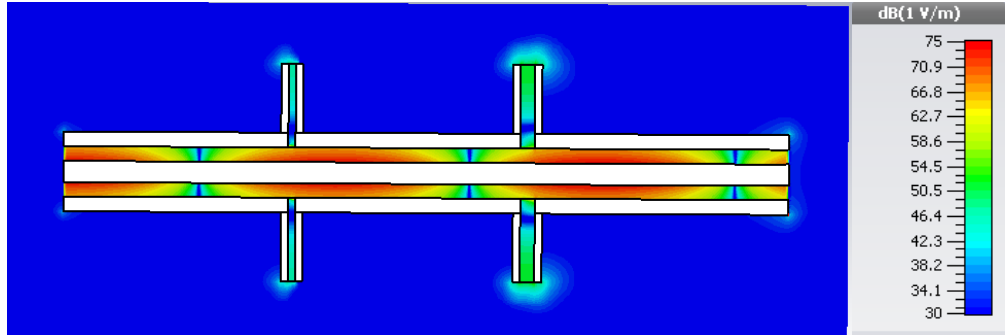
Figure 11. Field snapshot across the line with gaps at a frequency of 4 GHz (spacers made from acetal homopolymer).